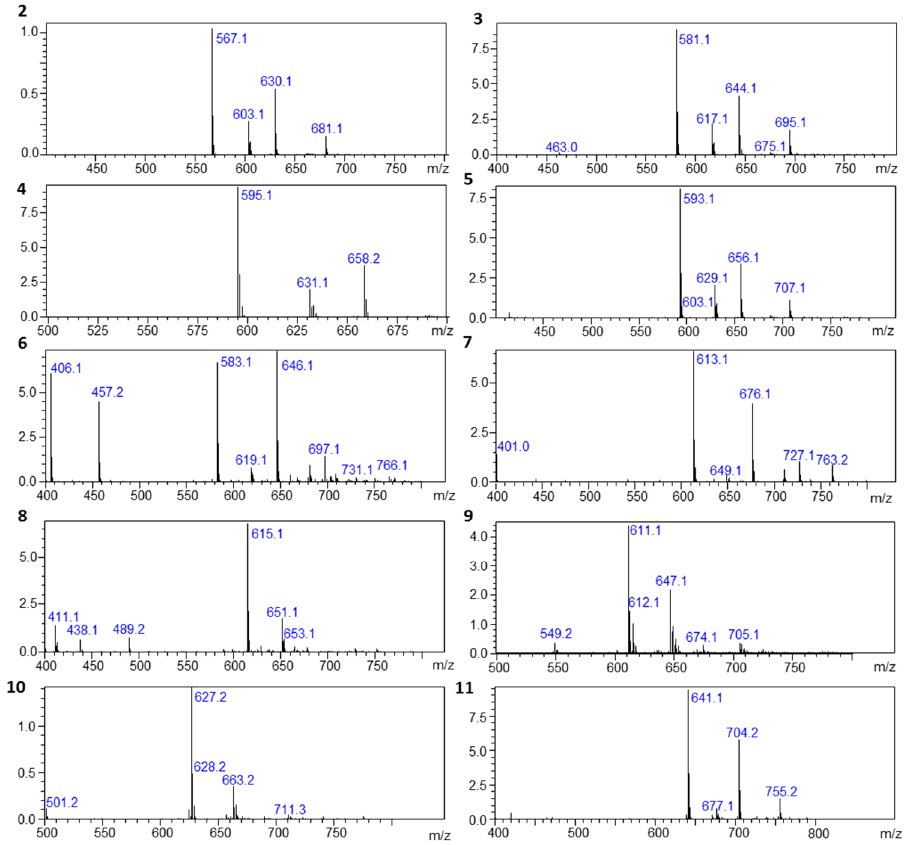
Figure 5. MS-ESI spectra of the isoquercitrin esters 2 – 11 .